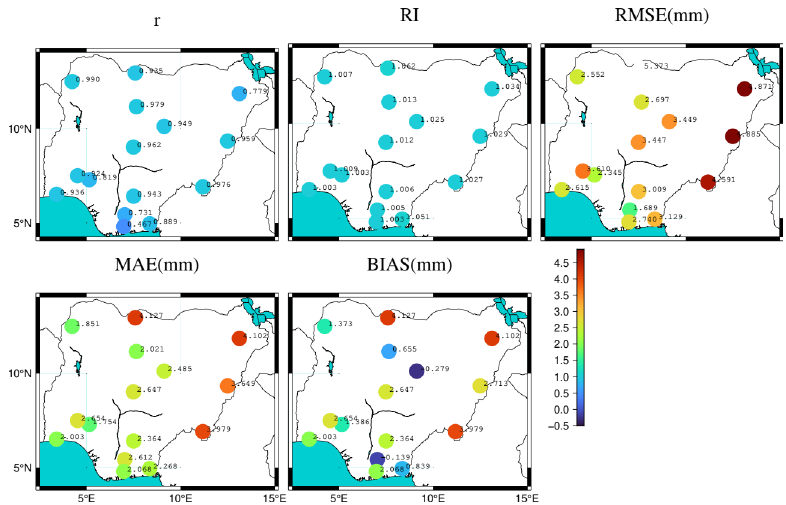
Figure 10. Statistical plot of diurnal agreement of PWV from ERA5 and GNSS from